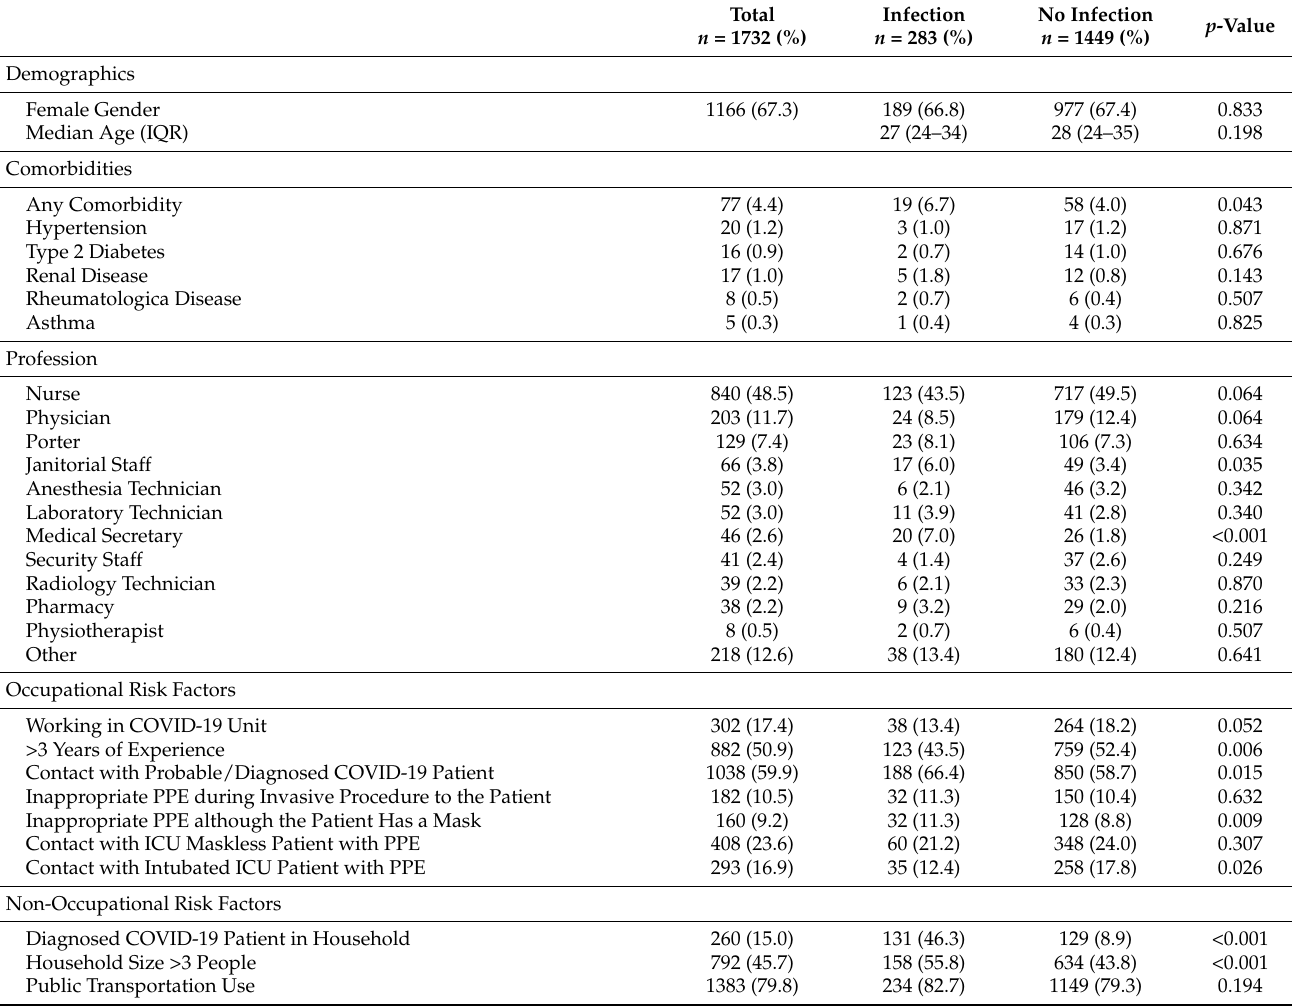
Table 1. Characteristics and risk factors for SARS-CoV-2 infection.